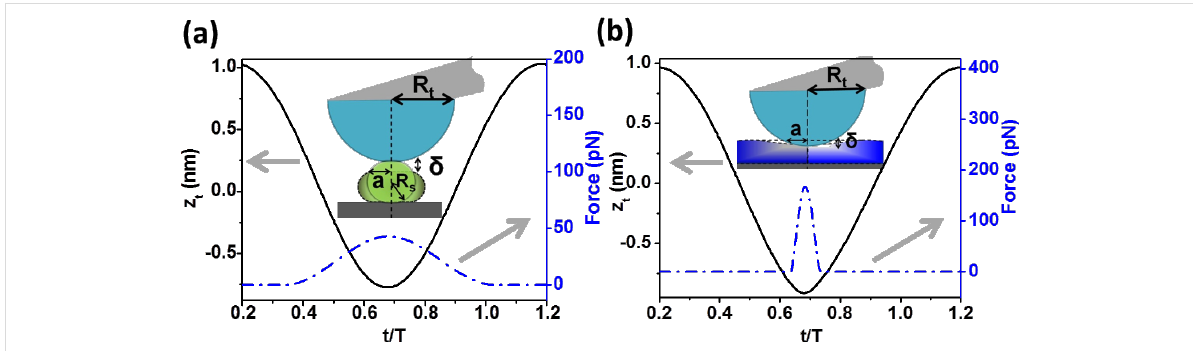
Figure 1: Peak forces, tip motion and contact time for two materials. (a) Soft sample ( E s = 50 MPa) simulated with the Tatara interaction force (Equa- tion 4). (b) Rigid sample ( E s = 2 GPa) simulated with the Hertz interaction force (Equation 3). Simulation inputs: k = 0.1 N/m, f 0 = 25 kHz, Q = 2, A 0 = 1 nm, R t = 5 nm, R s = 4 nm and A sp = 0.9 A 0